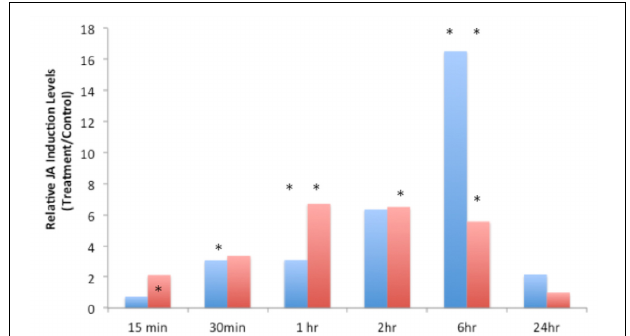
FIGURE 2 | Relative Jasmonic Acid levels in WT Arabidopsis plants after S. exigua and P. rapae feeding over a 24-h time course-JA was measured by UPLC-MS/MS as pmol/g fresh weight. Blue bars represent JA levels in S. exigua treatments/controls. Red bars in represent JA levels in P. rapae treatments/controls. Asterisks represent time points where JA levels in the treatment plants were significantly greater than controls as determined by the GLM method in SAS ( p < 0 . 05).